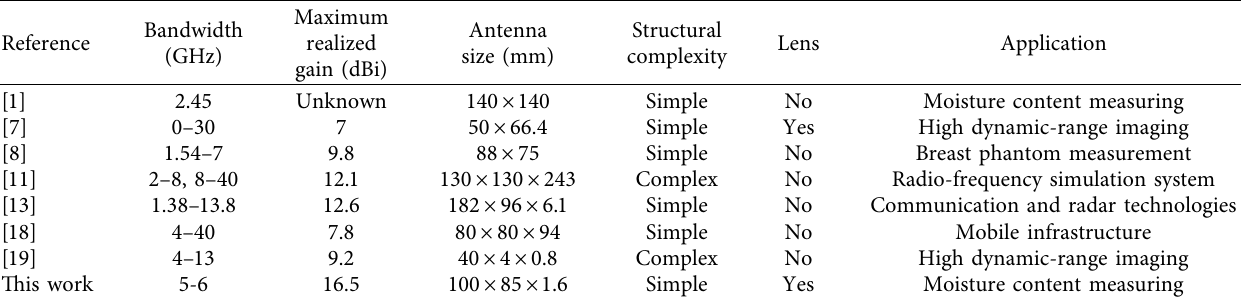
Table 2: Performance comparison among different